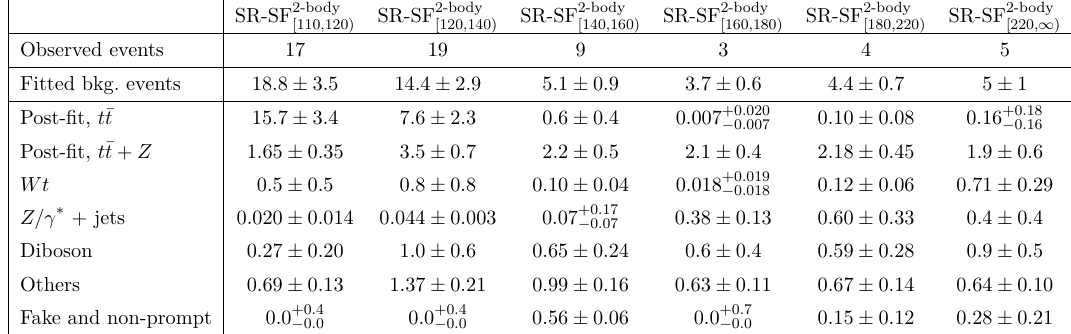
Table 16 . Two-body selection. Background fit results for the same-flavour leptons binned SRs. The ‘Others’ category contains the contributions from V V V , tt t , tttt , tt W , tt WW , tt WZ , tt H , and tZ . Combined statistical and systematic uncertainties are given. The individual uncertainties can be correlated, and do not necessarily add up in quadrature to the total background